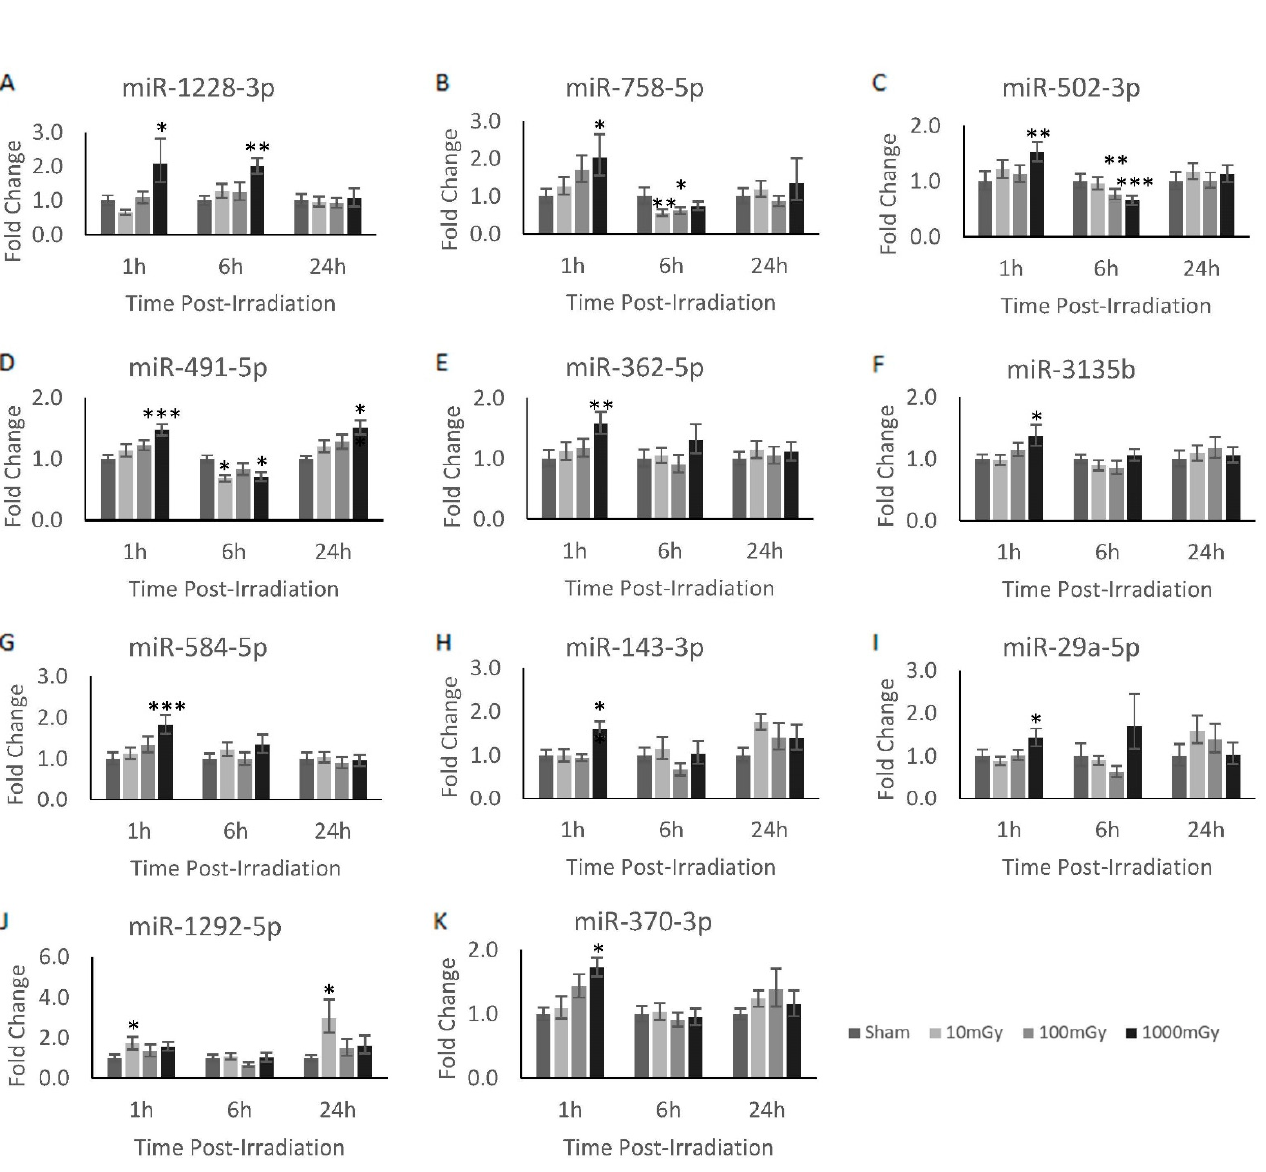
Figure 1. Radiation-induced miRNA dysregulation in CGL1 cells. Various doses and timepoints were analyzed via RT-qPCR to obtain the temporal expression profile of the analyzed miRNAs in CGL1 cells. Cells were irradiated at 10, 100, and 1000 mGy and collected 1, 6, and 24 h post-irradiation. All irradiation doses were normalized to their own timepoint’s sham condition to obtain the relative fold change. All miRNA shown had at least one dose and timepoint that was considered significant; however, most of the significant findings were shown to be at the 1000 mGy dose. Significance is denoted by an asterisk, where * p < 0.05, ** p < 0.01, and *** p < 0.001.